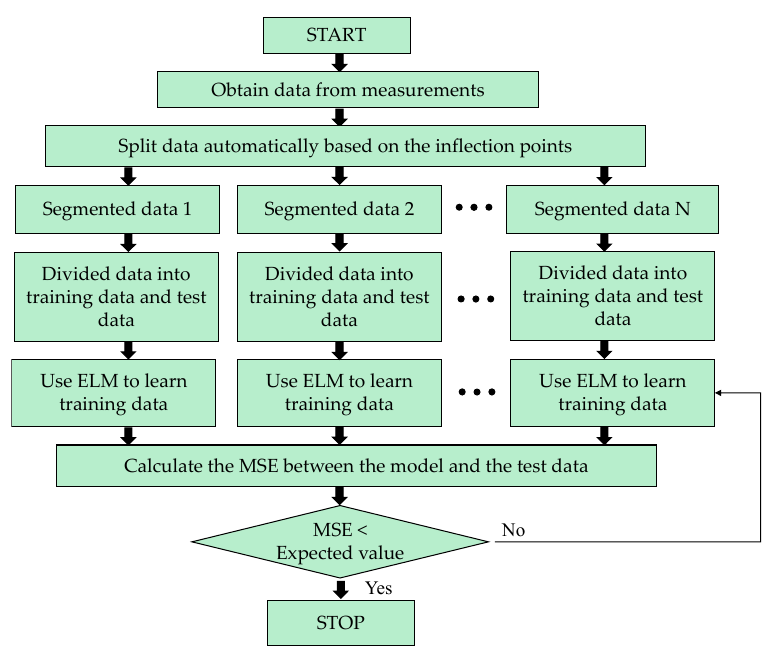
Figure 2. Flow chart of auto-PW ELM method.